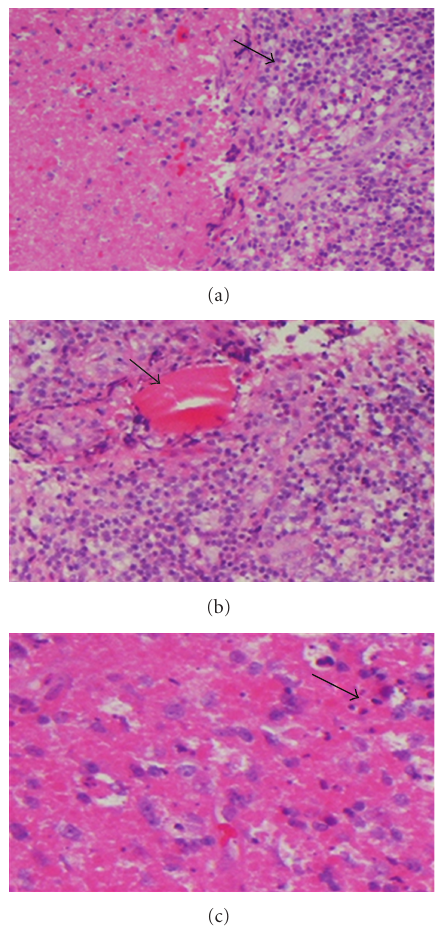
Figure 1: Hematoxylin- and eosin-stained section showing histo- logical appearance of a lymph node biopsy in medium (a) and high (b, c) magnifications. (a) Lymph node showing necrosis and mononuclear cell infiltrate (arrow). (b) Brick red necrosis (arrow). (c) Apoptosis and nuclear dust (arrow). (a, b, and c) x10 (original